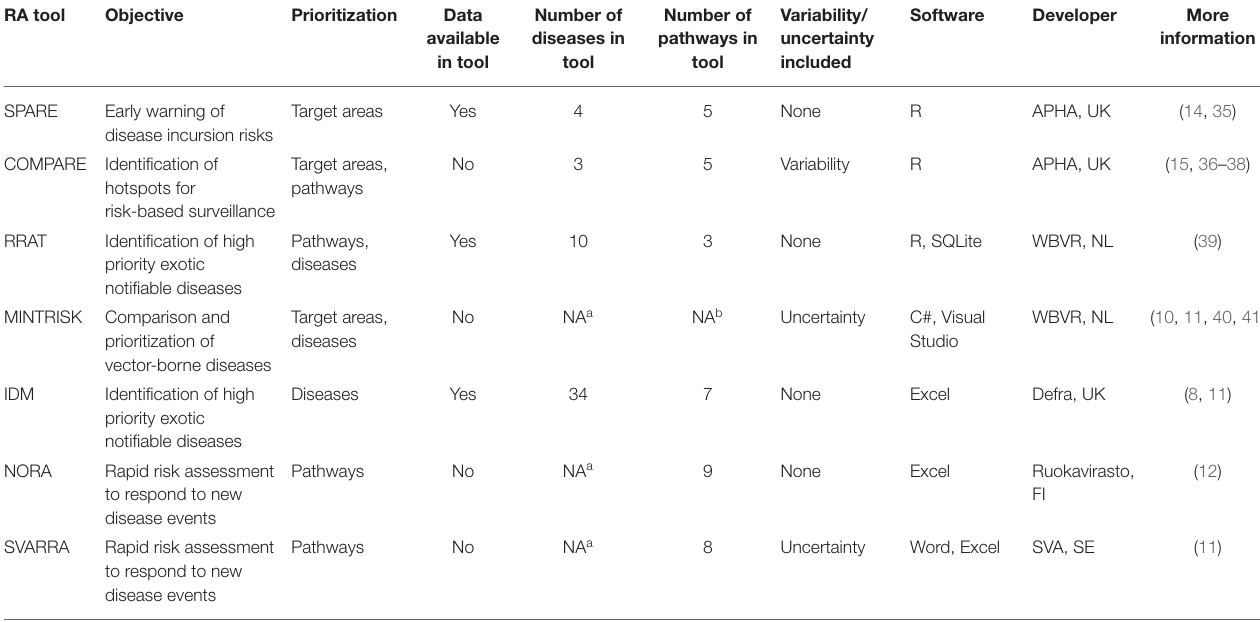
TABLE 1 | Brief outline of seven generic RA